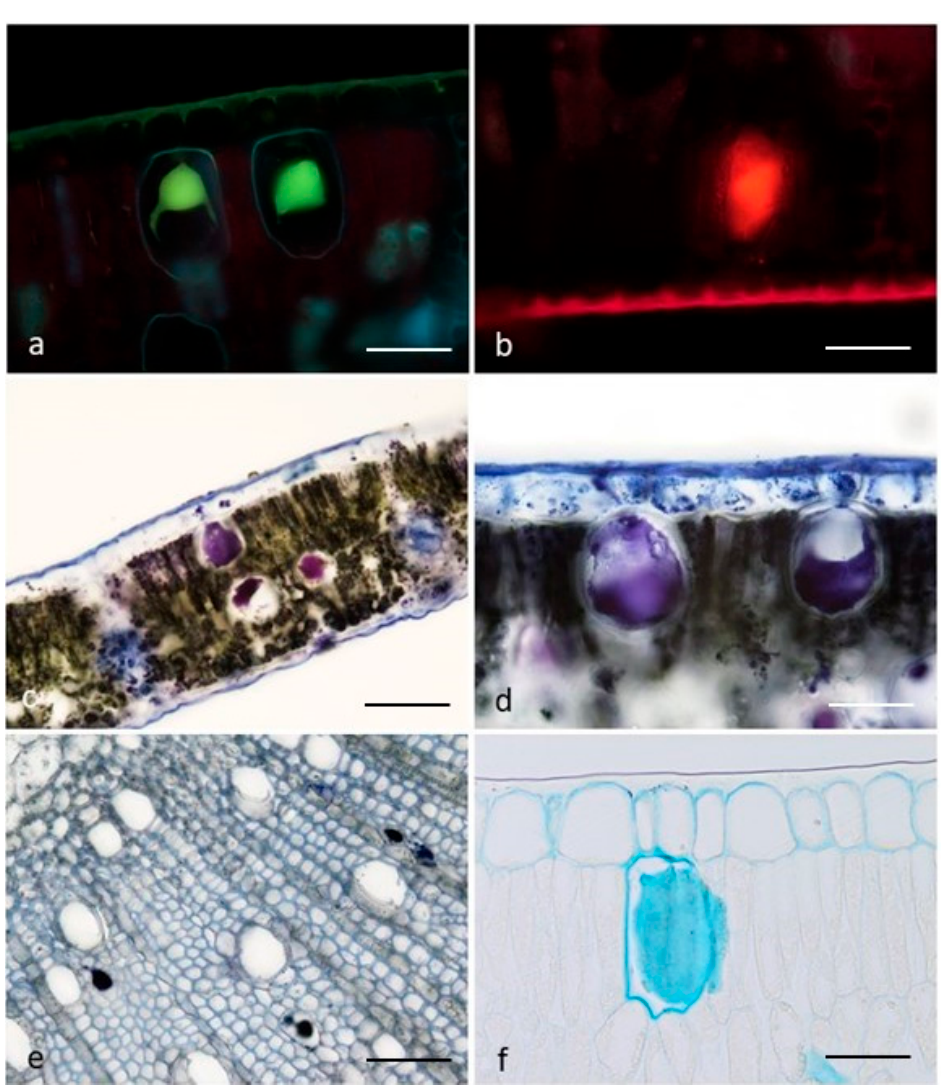
Figure 2. Results of the histochemical investigation on the secretory material of the oil cells ( a – e ) and of the mucillage cells ( f ): Fluoral Yellow-088 ( a ); Nile Red ( b ); Nadi reagent in leaves ( c , d ) and young stems ( e ); Alcian Blue ( f ). Scale bars = 50 μ m ( a , b , d – f ); 100 μ m ( c ). Table 1. Results of the histochemical analysis on the leaves and young stems of Cinnamomum